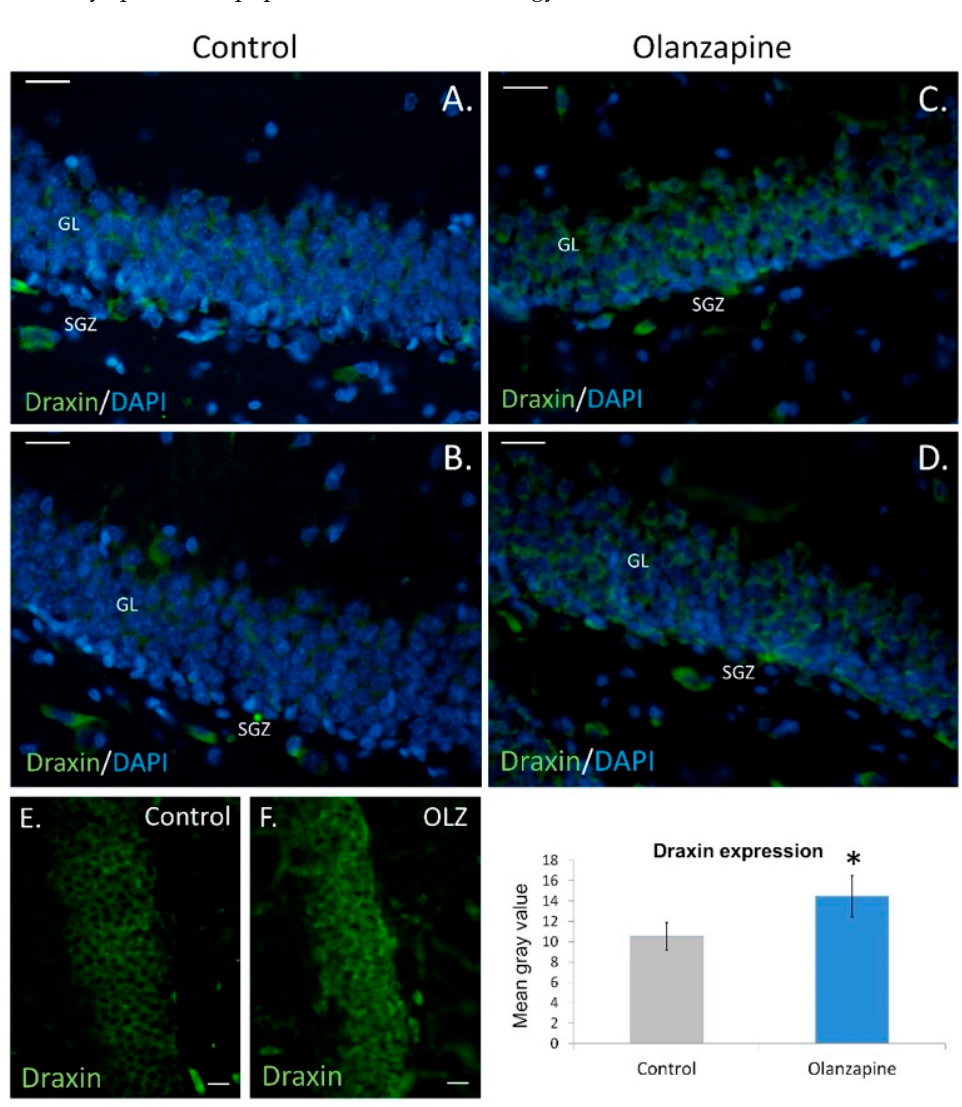
Figure 1. Draxin expression in the rat hippocampus. Control ( A , B ), olanzapine ( C , D ). Microphotographs show granular layers (GL) and subgranular zones (SGZ) of dentate gyrus with disperse draxin fluorescence. Scale bars: 20 μ m ( A – D ), 10 μ m ( E , F ). Mean gray value of sections examined in the study + standard error of the mean (SEM), * p < 0.05.